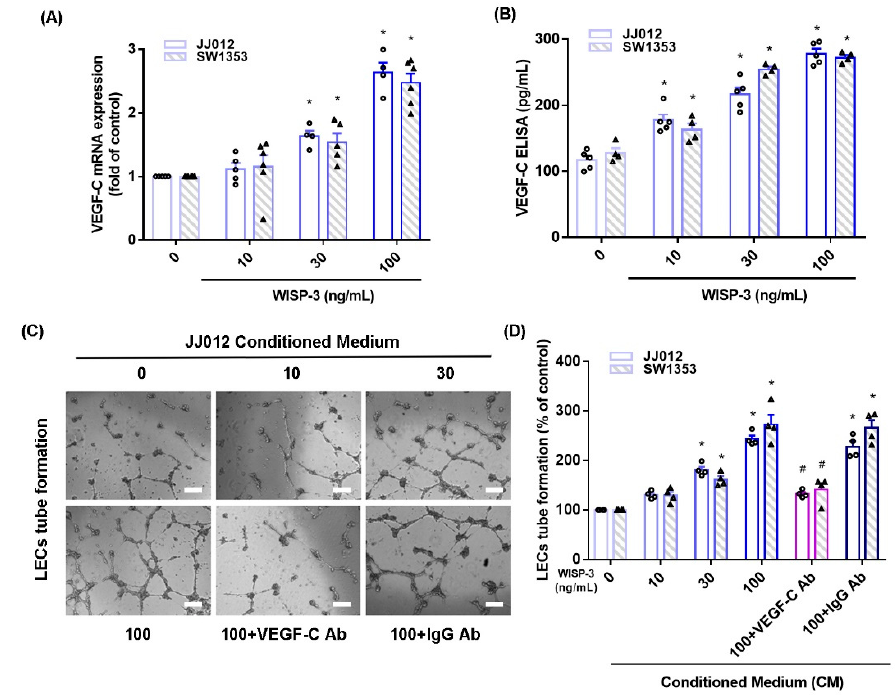
Figure 1. WISP-3 promotes VEGF-C-dependent lymphangiogenesis in human chondrosarcoma . ( A , B ) Cells were incubated with WISP-3 (10–100ng/mL) and levels of VEGF-C mRNA and pro- tein expression were examined by qPCR and ELISA assays. ( C , D ) Collected conditioned medium (CM) was applied to lymphatic endothelial cells (LECs), then LEC tube formation was measured (scale bar = 100 µ m). Quantitative results are expressed as the mean ± SD. All experiments were repeated 3 to 5 times (solid squares, solid dots, hollow circles and solid triangles). * p < 0.05 compared with the control group; # p < 0.05 compared with the WISP-3-treated